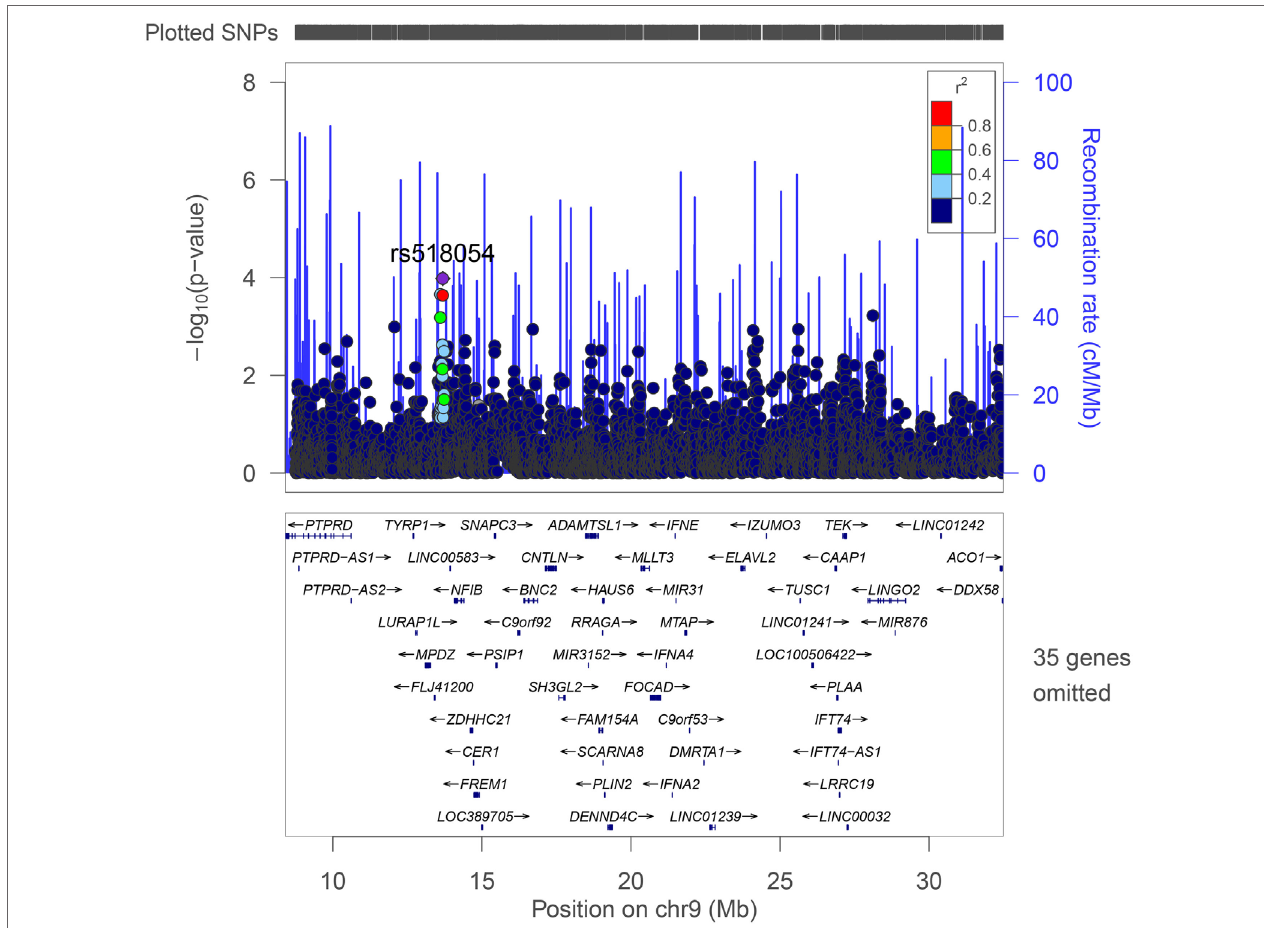
FigUre 1 | LocusZoom plot of the region studied with frailty on chromosome 9p21-23. Genes and ESTs within the region are shown in the lower panel, and the unbroken blue line indicates the recombination rate within the region. Each filled circle represents the p -value for one SNP, with the top SNP rs518054 shown in purple and SNPs in the region colored depending on their degree of correlation ( r 2 ) with rs518054 [as estimated internally by LocusZoom on the basis of CEU (Utah residents of Northern and Western European ancestry) HapMap